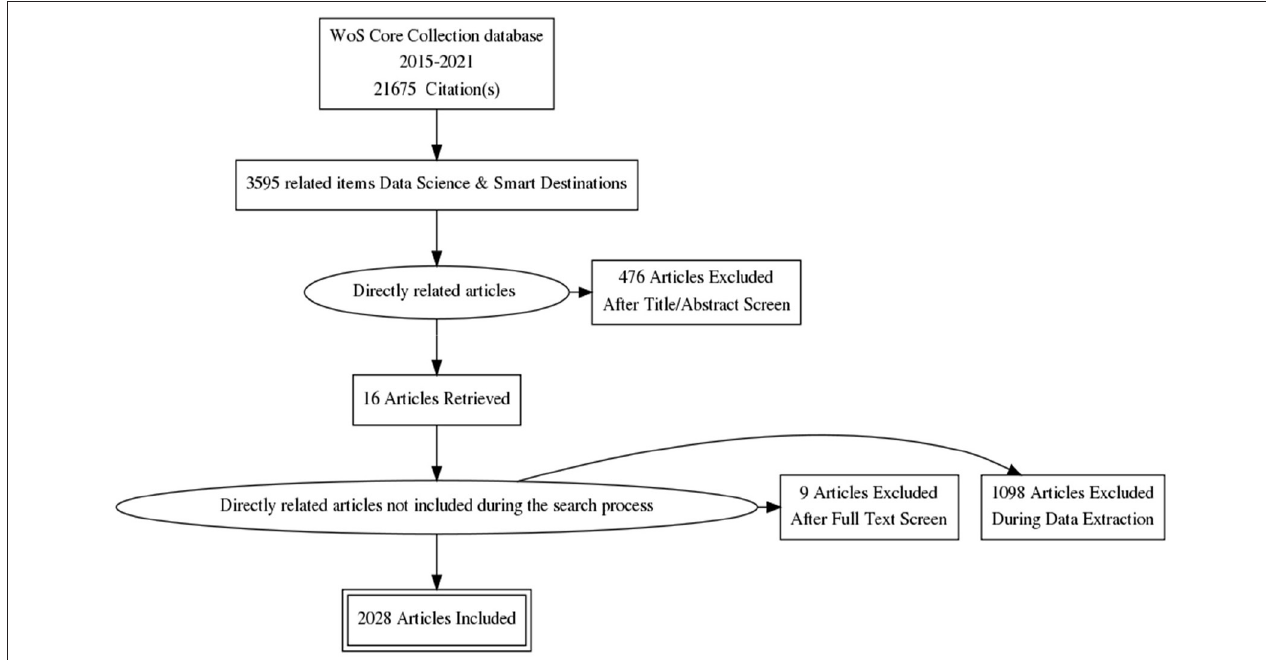
FIGURE 1 | Systematic review flowchart. Source: prepared by the authors using PRISMA Flow Diagram